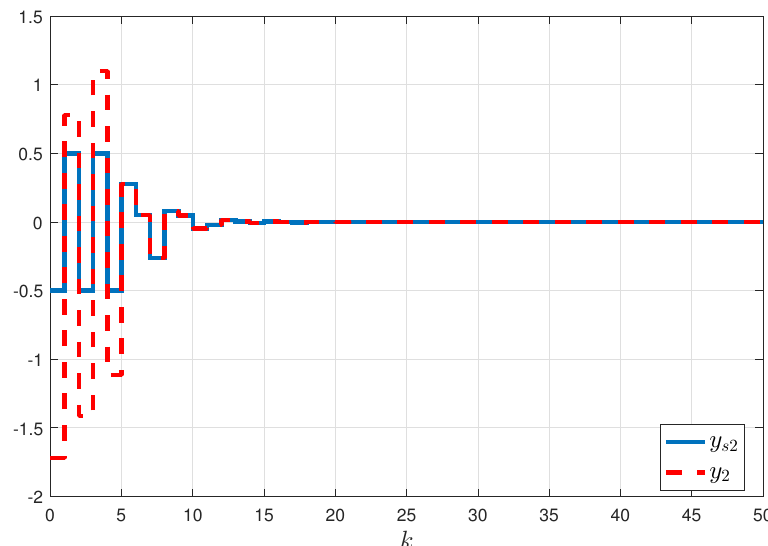
Figure 2. Actual and ideal measurements of y 2